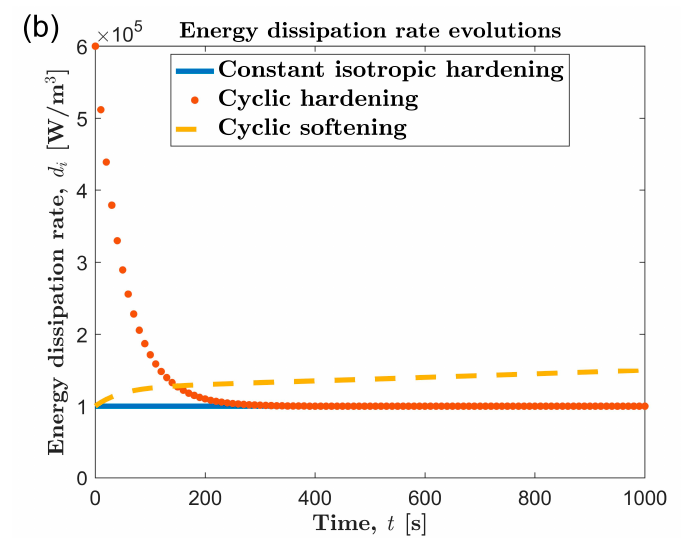
Figure 7. ( a ) Temperature evolution curves and ( b ) energy dissipation rate evolution curves for different hardening types.